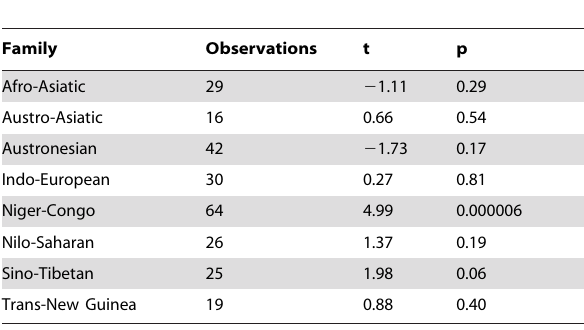
Table 4. Tone and acacia trees by language family